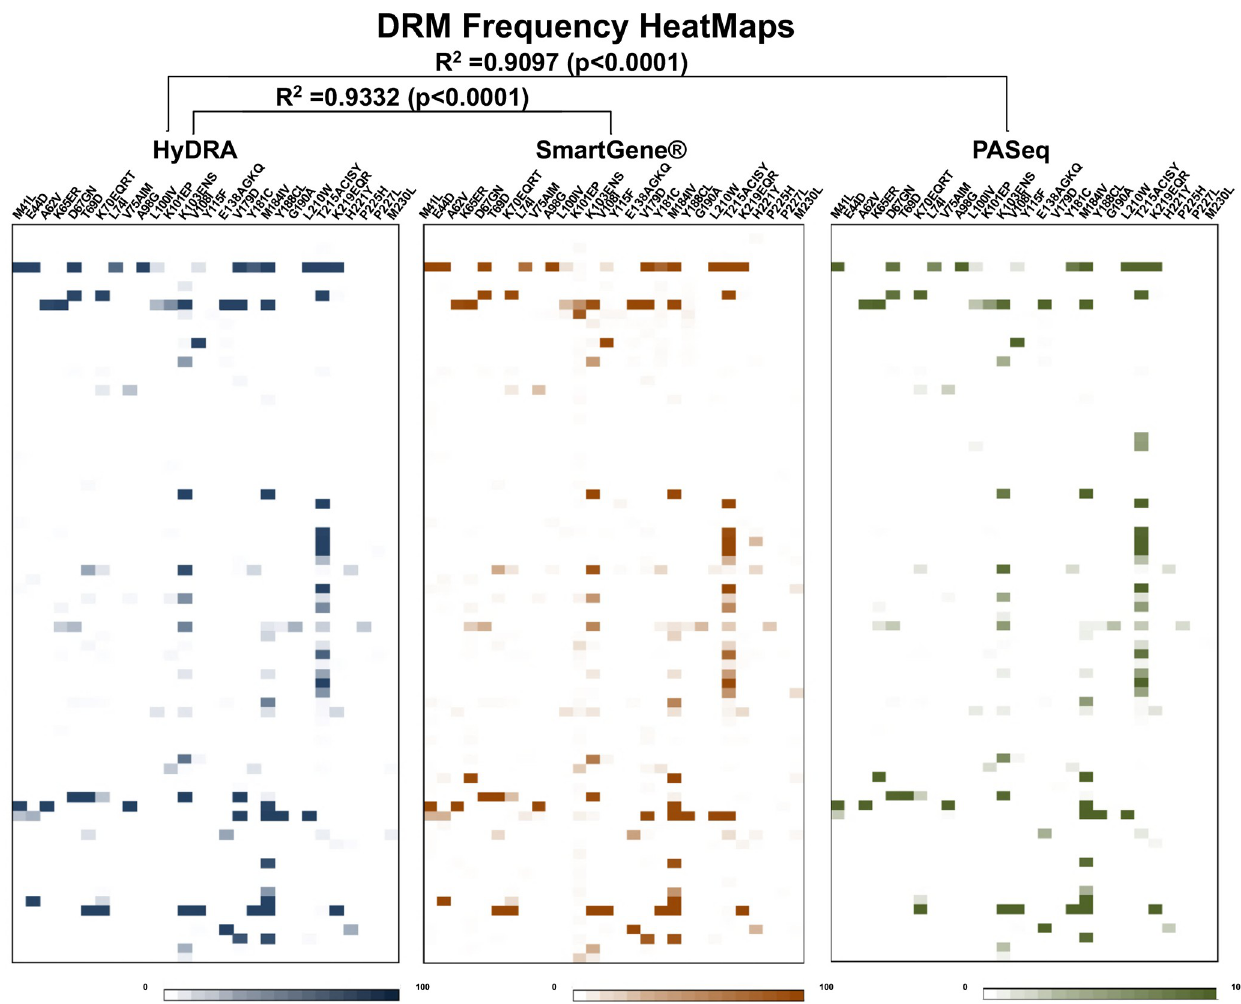
Fig 4. RT DRM frequency data represented as HeatMaps from three different pipelines. Using Microsoft Excel conditional formatting function was applied to generate a color gradient from white (0% DRM) to darkest color (100% DRM). The pipelines used included HyDRA Web (blue colored scheme), SmartGene (brown colored scheme) and PASeq Web (green colored scheme). Above each of the 3 Heatmaps is the key to amino acid changes. The numbers located on the far-left hand side of the figure represents specimen study numbers listed in numerical order.